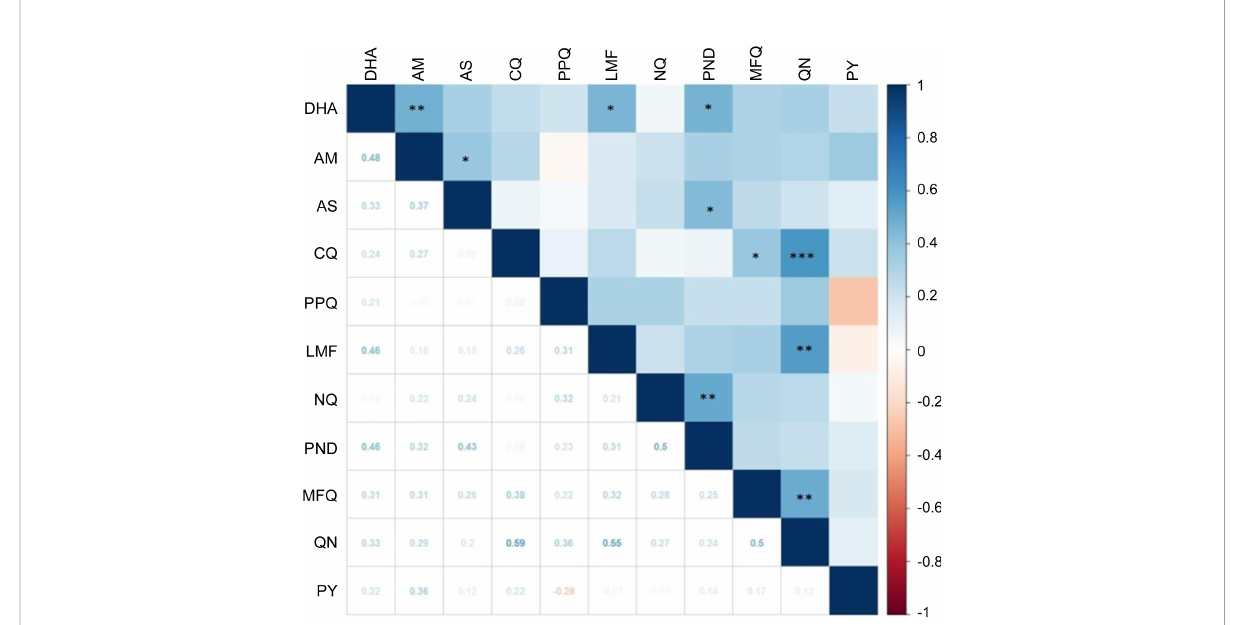
FIGURE 2 Correlation of in vitro susceptibility (IC 50 values) of 29 parasite isolates to 11 antimalarial drugs analyzed by Spearman ’ s test. The magnitude and direction of associations between IC 50 values are indicated by color and values. The coef fi cients are shown below the diagonal, while statistical signi fi cance is marked above the diagonal with *, **, and *** indicating signi fi cance at P < 0.05, < 0.01, and < 0.001, respectively. Drug abbreviations are the same as in Figure